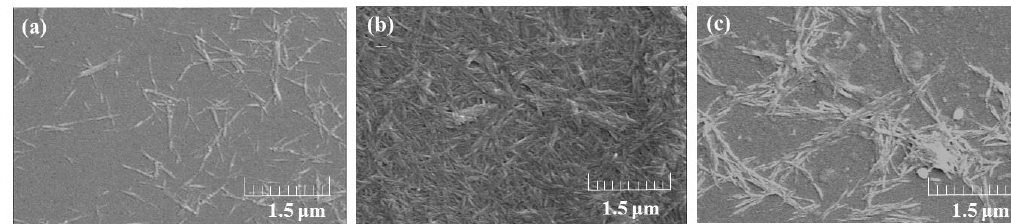
Figure 3. Scanning electron microscopy (SEM) images of ( a ) dispersion in methanol; ( b ) film; and ( c ) redispersion in 1 mol/L ammonia aq. of self-assembled CNFs.